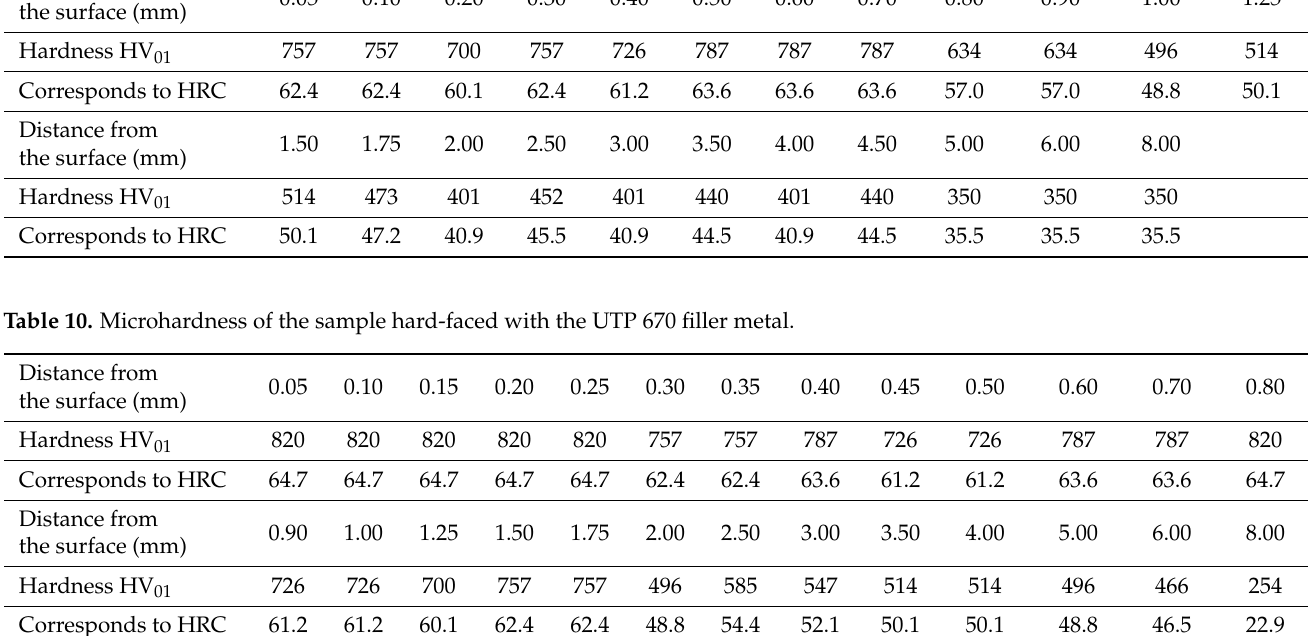
Table 9. Microhardness of the sample hard-faced with the Castolin 2 filler metal. Distance from the surface (mm)